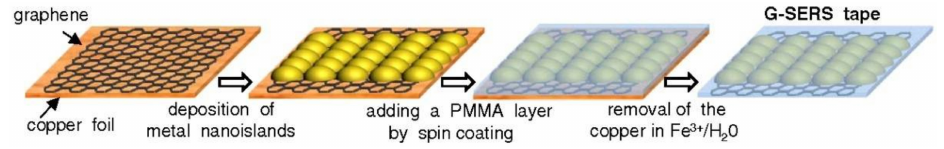
Figure 4. Schematic steps of the preparation route flexible G-SERS tape prepared from CVD-grown monolayer graphene. Reproduced from [27] with permission; Copyright PNAS 2012.